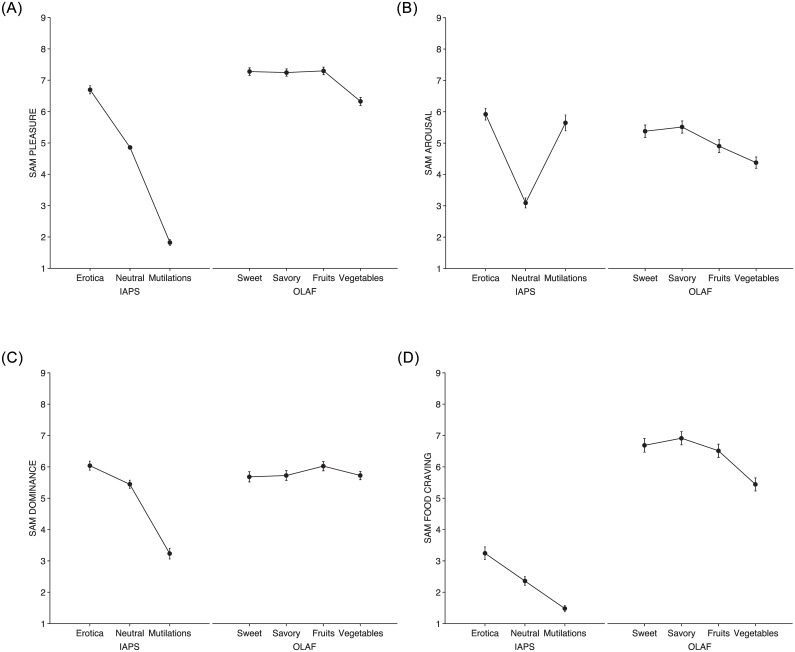
SAM ratings across IAPS and OLAF picture categories for pleasure (2a), arousal (2b), dominance (2c), and food cravings (2d).Erotica, neutral objects, and mutilations prompted the typical patterns in the dimensions of pleasure, arousal, and dominance. For foods, pleasure and arousal jointly provided the more reliable description of the emotional impact of specific food categories, distinguishing more clearly than the other dimensions between sweet and savory high-calorie foods and low-calorie fruits and vegetables. On the contrary, as in our previous work [17], food cravings were less capable of pinpointing the emotional impact of different food categories.